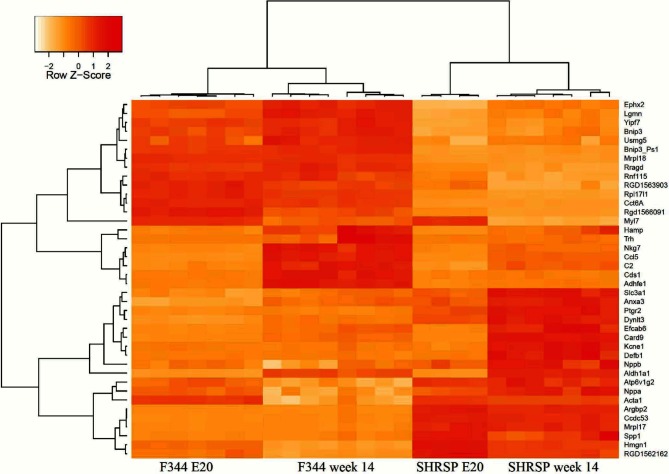
Hierarchical clustering of differentially expressed genes.Hierarchical clustering of differentially expressed genes (log fold change > |1.5| and p < 0.01) between SHRSP and F344 in week 14 over all samples. Samples (columns) and genes (rows) are grouped by their expression profile. Expression values are scaled by Z-Score with zero mean and standard deviation of 1. Values above the mean are shown in red, equivalent to the mean are colored in yellow and below the mean in white. Animal samples of F344 E20 (n = 7), F344 week 14 (n = 8), SHRSP E20 (n = 4) and SHRSP week 14 (n = 7) are in order at the bottom.